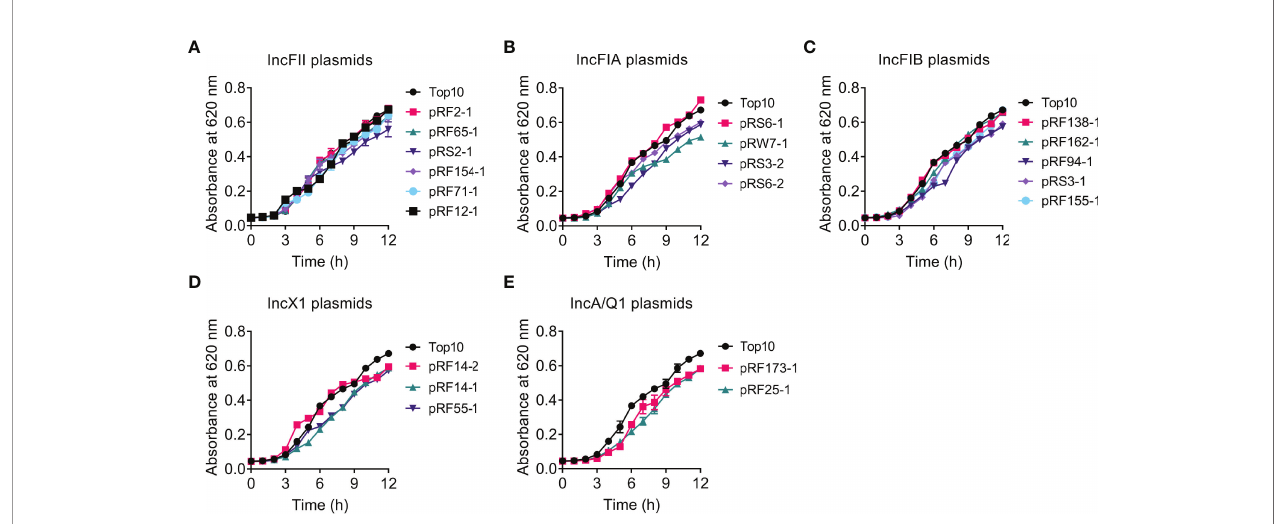
FIGURE 1 | Effects of tet (X4)-positive plasmids on the growth rate of transformants. Growth curves of TOP10 and transformants carrying tet (X)-positive IncFII (A) , IncFIA (B) , IncFIB (C) , IncX1 (D) , or IncA/Q1 (E) plasmids during 12 h. Y axis, absorbance of bacterial cultures at 620 nm; X axis, time of bacteria growth